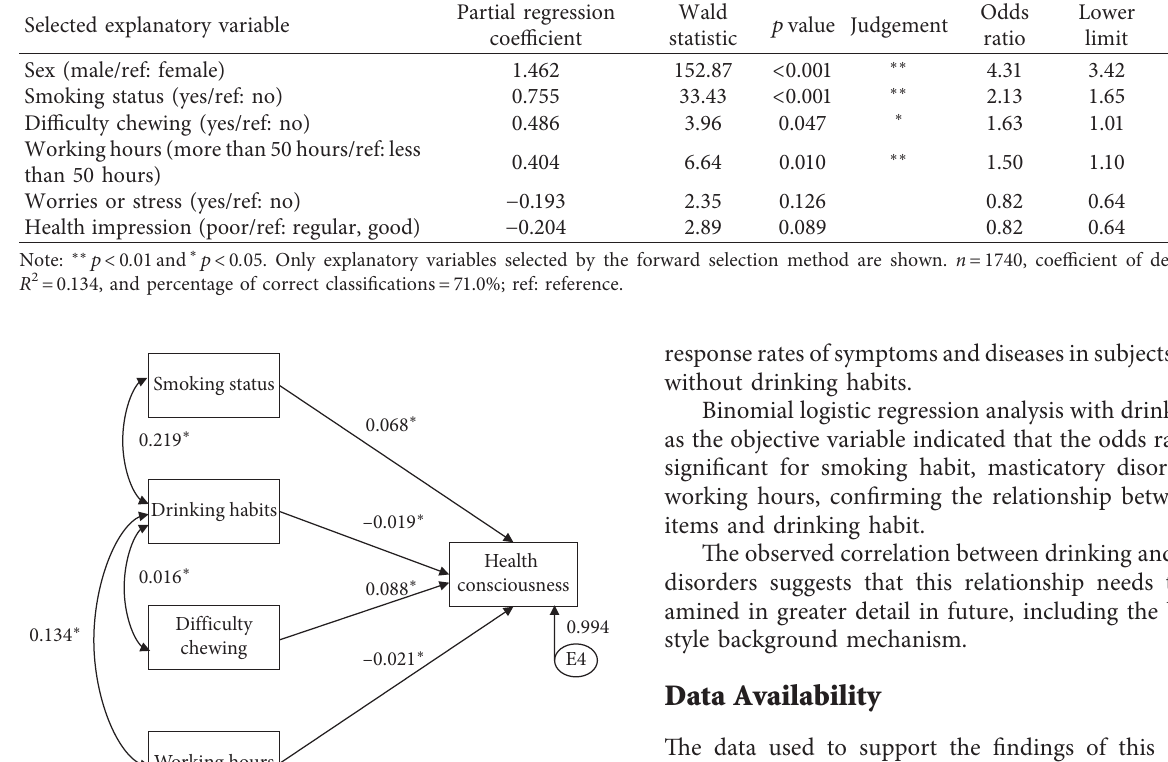
Table 6: Results of logistic regression analysis in relation to drinking habit. Partial regression coefficient significance test